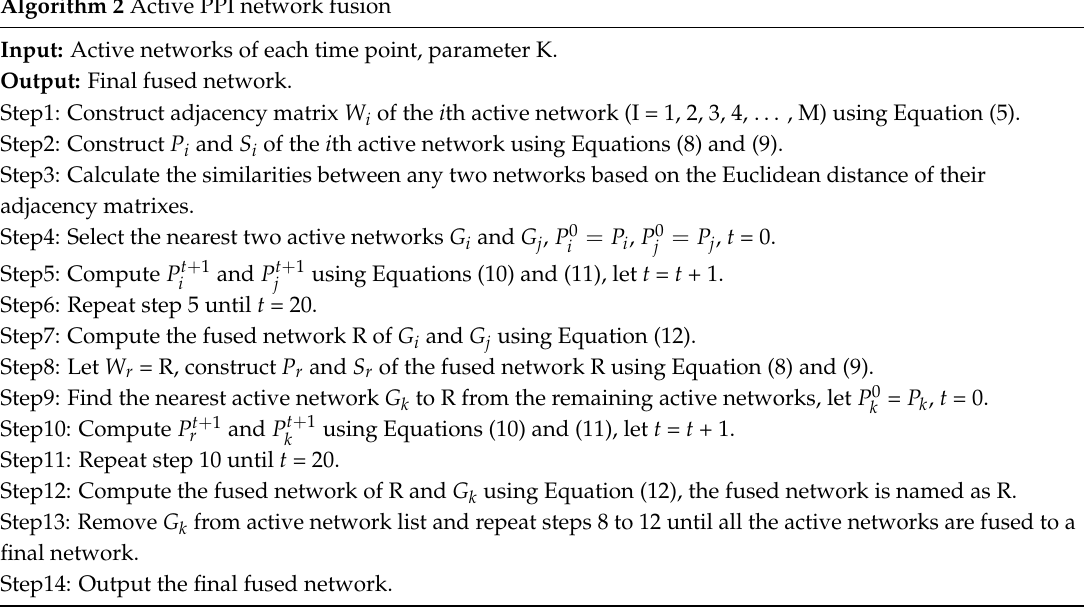
Algorithm 2 Active PPI network